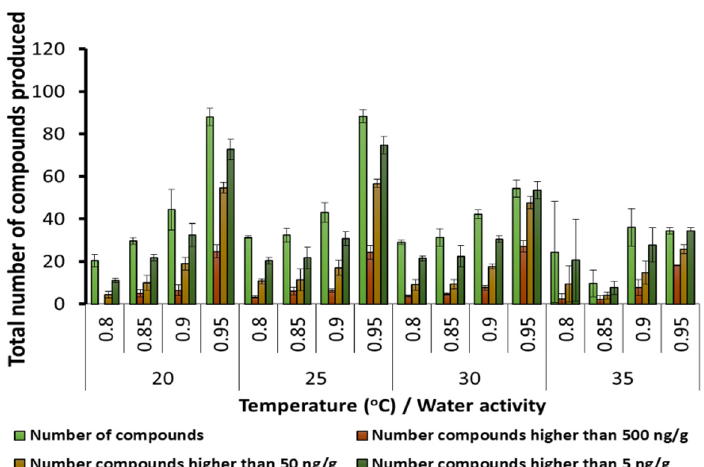
Figure 2. The effect of storage temperature and water activity on the total number of secondary metabolites and the number of compounds present in groupings based on relative concentrations in stored maize grain. Bars represent the Standard Error of the mean (statistics available in Supplementary Materials Table S1).